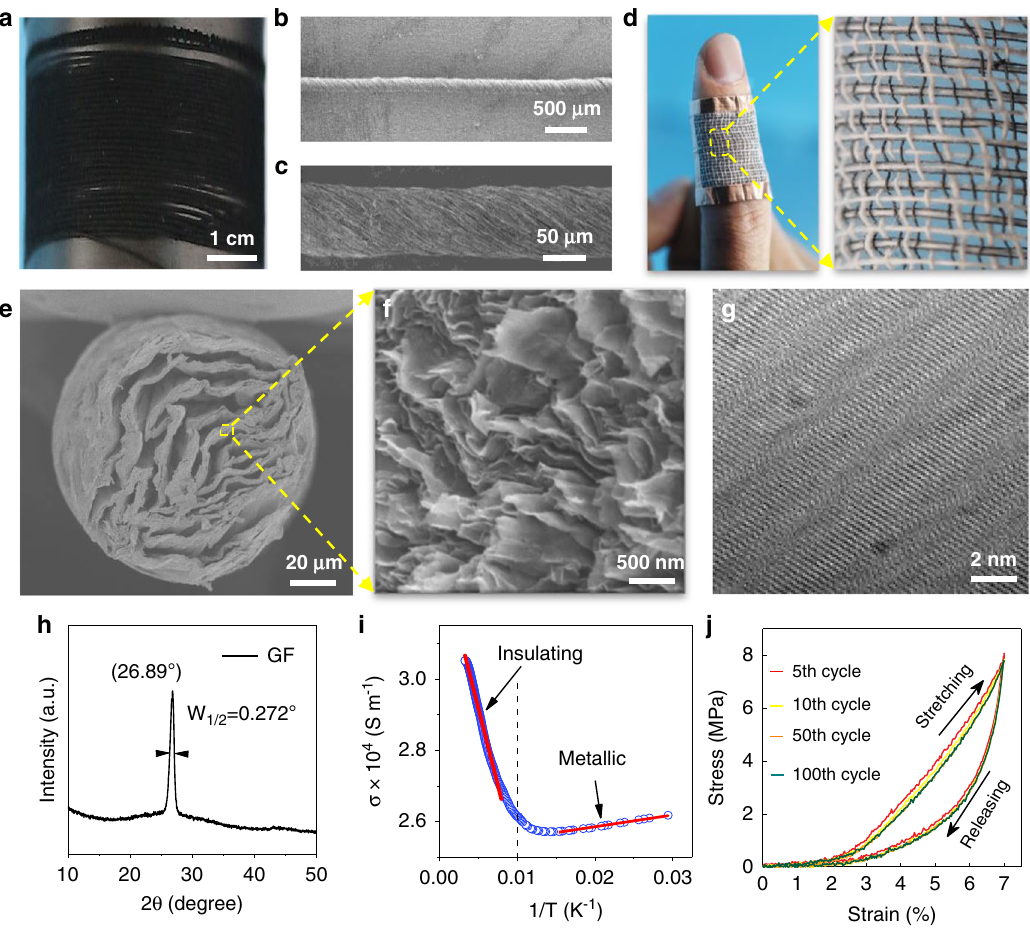
Fig. 1 Structural characteristics of GFs. a Photograph of meters-long GF collected on a graphite roller. b , c SEM images of the GF surface at different magni fi cations. d Weaving continuous GFs into a cotton cloth and wearing the composite fabric on a fi nger. e , f SEM images of GF cross-section showing randomly stacked graphene sheets. g TEM image of a crystallized graphene sheet in GF. h XRD spectrum of GF. The full width at half maximum ( W 1/2 ) of ~0.272° indicates restoration of ~29.7 nm thick graphene crystals in GF as described by Scherrer equation (LC = 0.9 λ /( W 1/2 cos θ )). i Four-point electrical conductivity of GF as a function of inverse temperature. j Mechanical durability test of GF up to 100